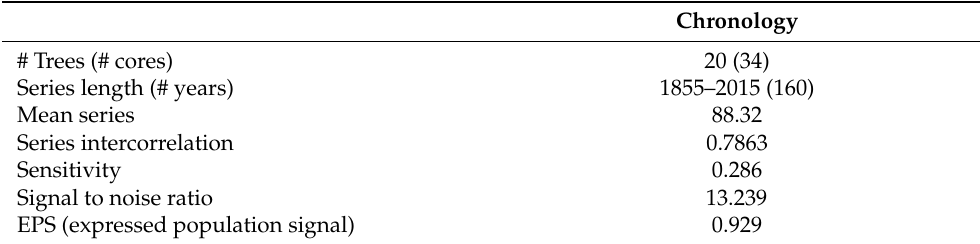
Table 1. Selected statistics for the Crestline ponderosa pine chronology in the San Bernardino Mountains of Southern